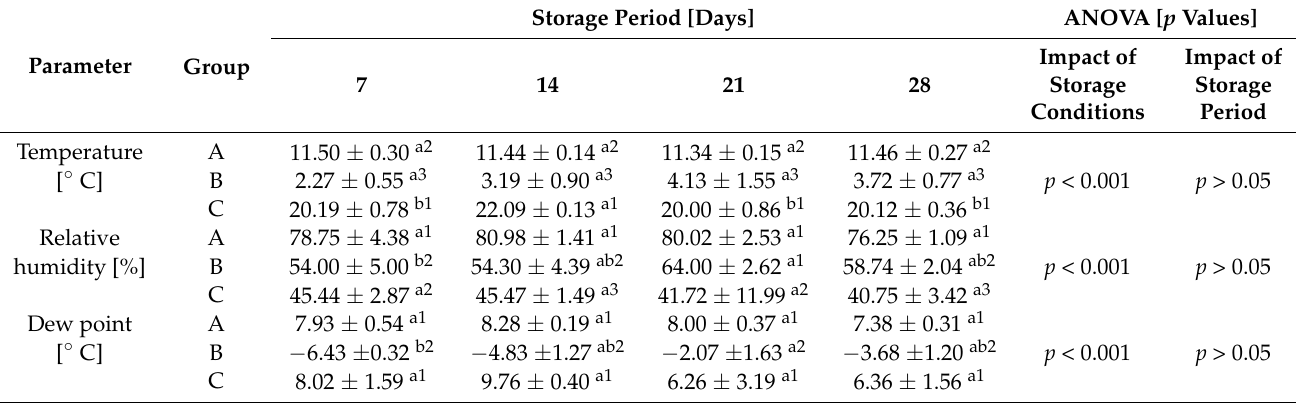
Table 1. Storage conditions for three experimental groups of table eggs (mean ± SD).